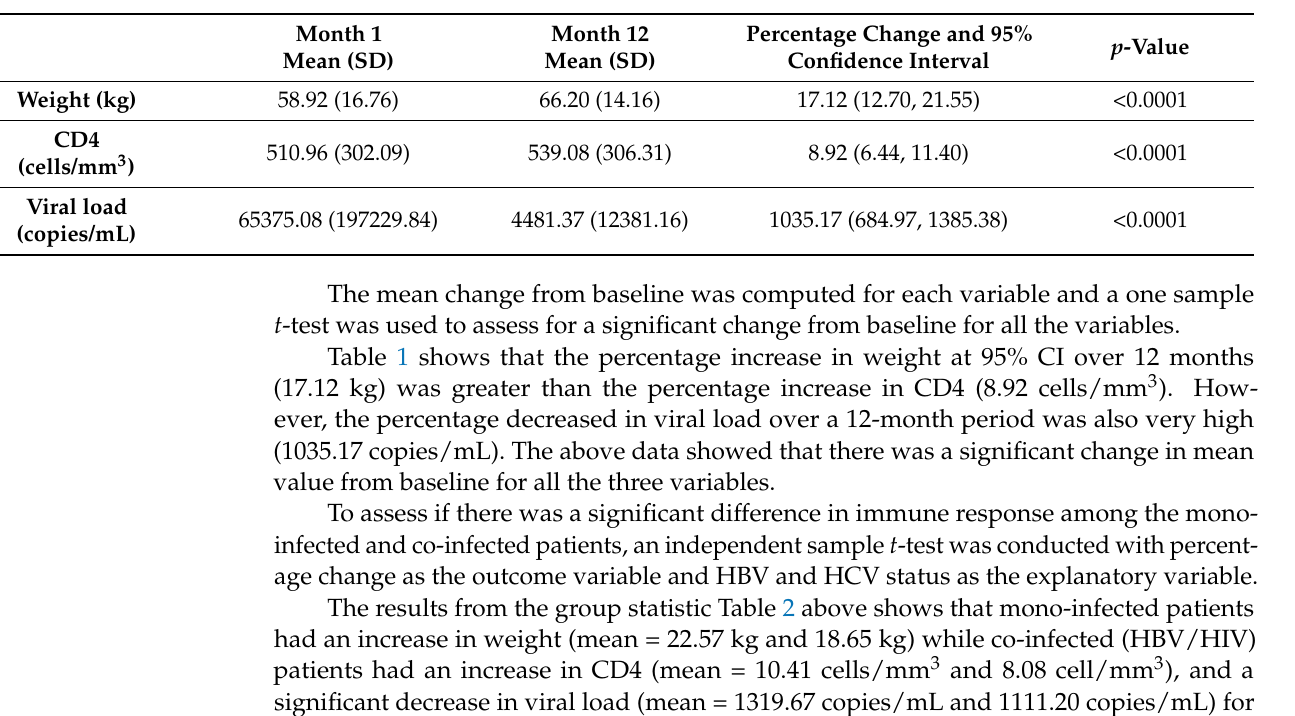
Table 1. Mean immune response measurements and percentage change between 1 and 12 months in both mono- (HIV) and co-infected (HIV and HBV; HIV and HCV)